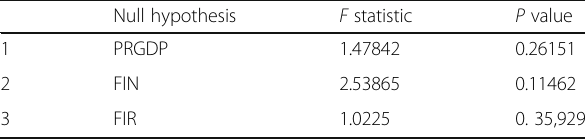
Table 3 Results of the Granger causality test between LNPRDGP and other indicators